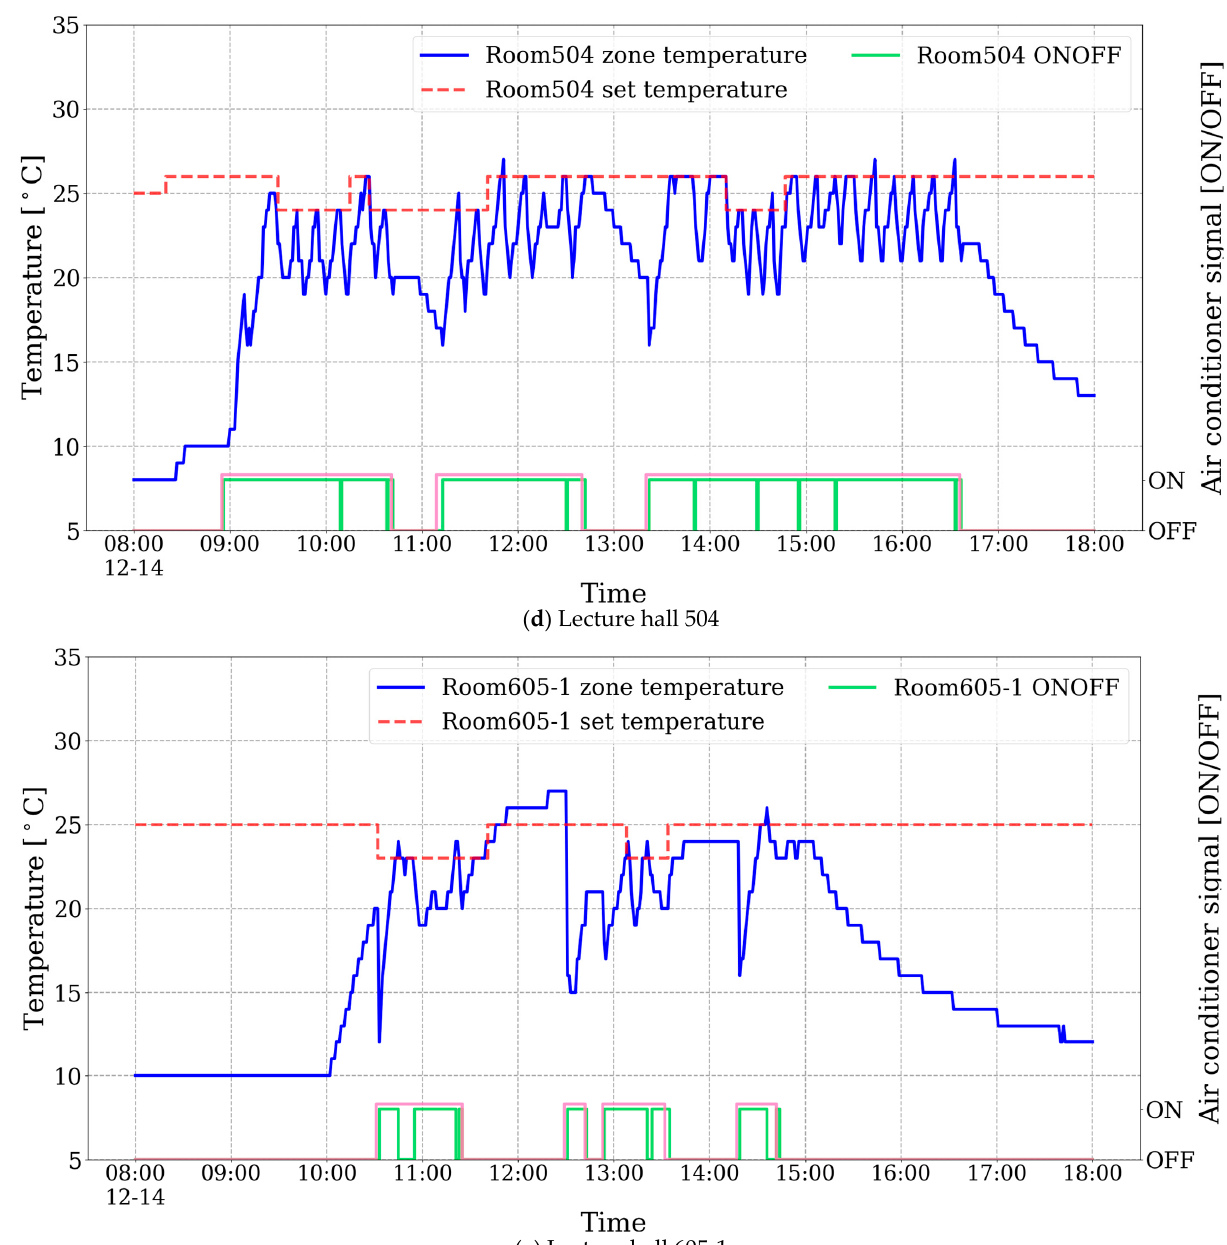
Figure 17. Reduction ratio 5% result of the field test with the zone temperature, set temperature, and air conditioners operating state applying the building control algorithm. ( a ) Lecture hall 205-1; ( b ) 3F lounge 2; ( c ) Lecture hall 403-2; ( d ) Lecture hall 504; ( e ) Lecture hall